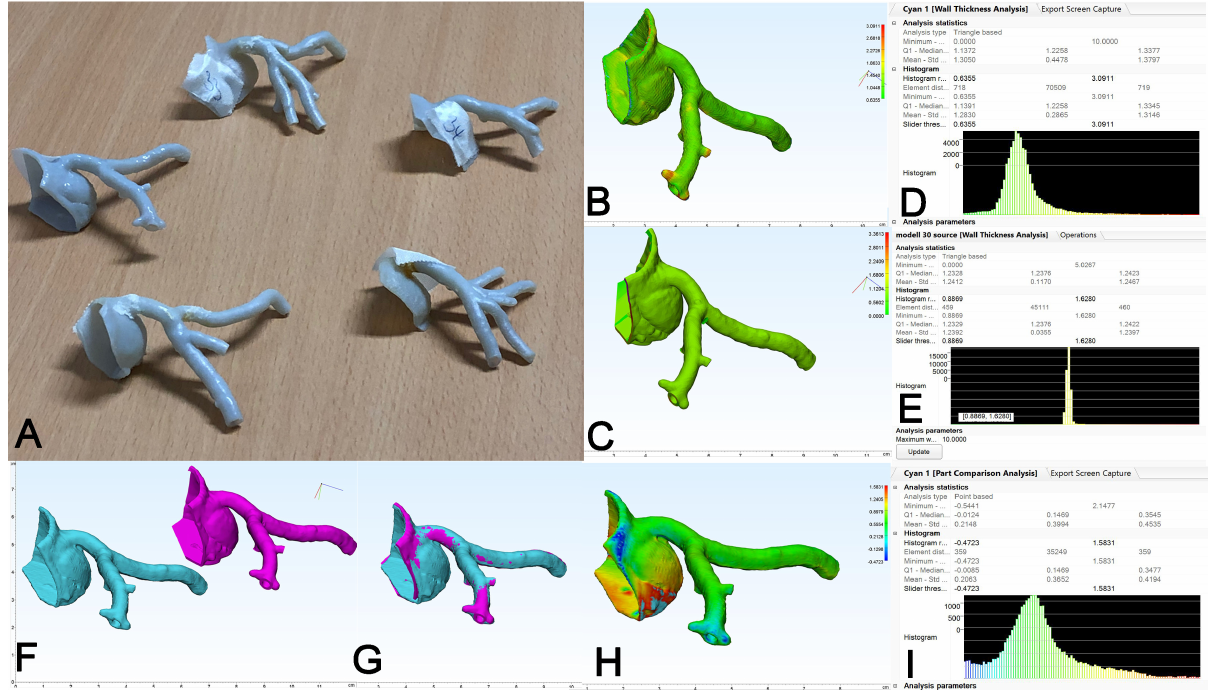
Figure 8. Representative examination of 3D model of coronary arteries. ( A ): 3D models of five different configurations of coronary arteries were generated and printed in flexible polymer (Stratasys Tango ® gray). ( B ): 3D model STL (cyan) and ( C ): source STL (fuchsia). ( D ): Color-coded map of WTA and histogram results of 3D model STL are shown. ( E ): Color map and histogram with sharp band of WTA of source STL for internal validation. ( F ): Source STL (fuchsia) and 3D model STL (cyan) were then semi-automatically aligned and overlayed ( G ). ( H ): Color map and ( I ): histogram results of PCA. Note surface deviation (hotspot) in yellow-red coding at coronary